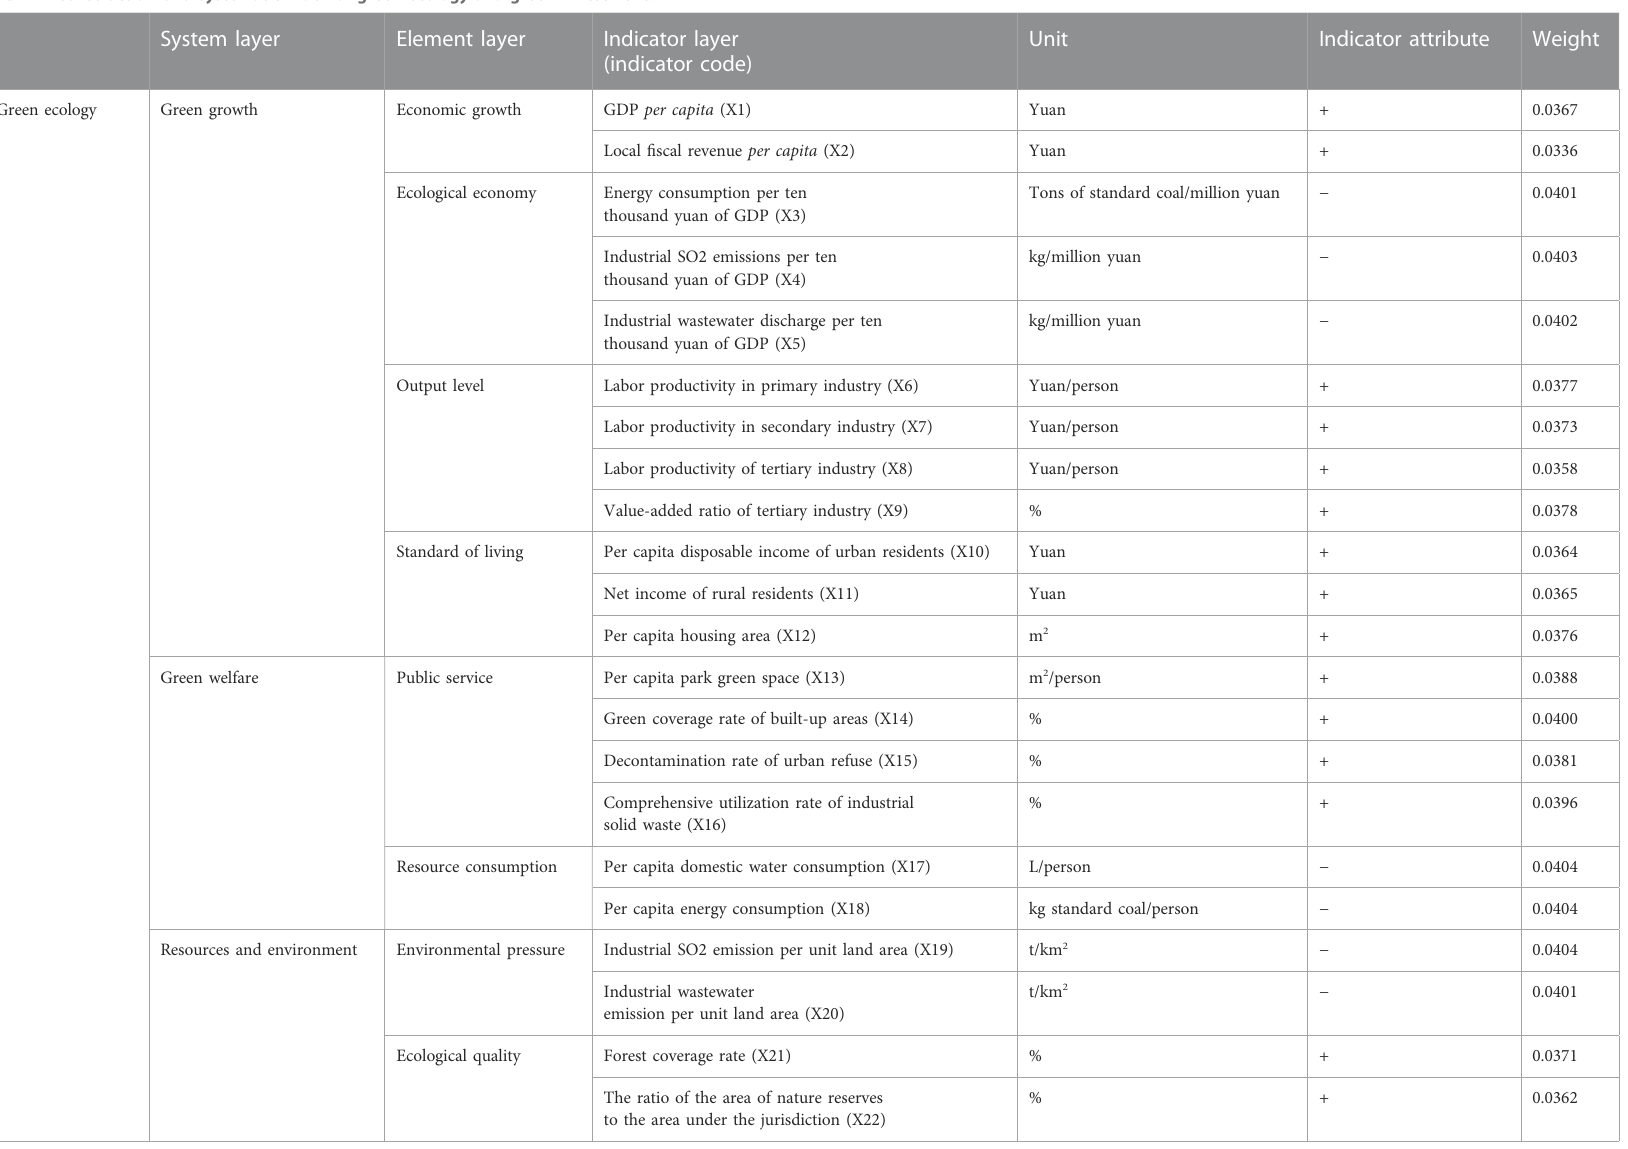
TABLE 1 Construction of a systematic index of green ecology and green